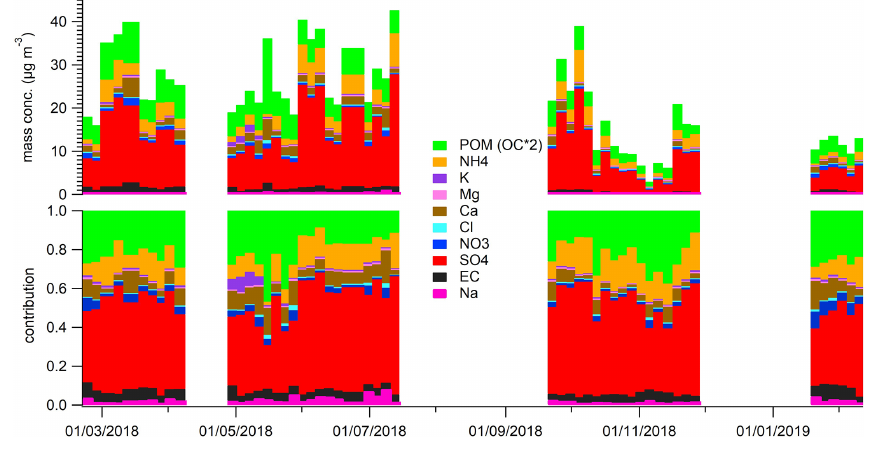
Figure 3. Aerosol particle chemical composition during the